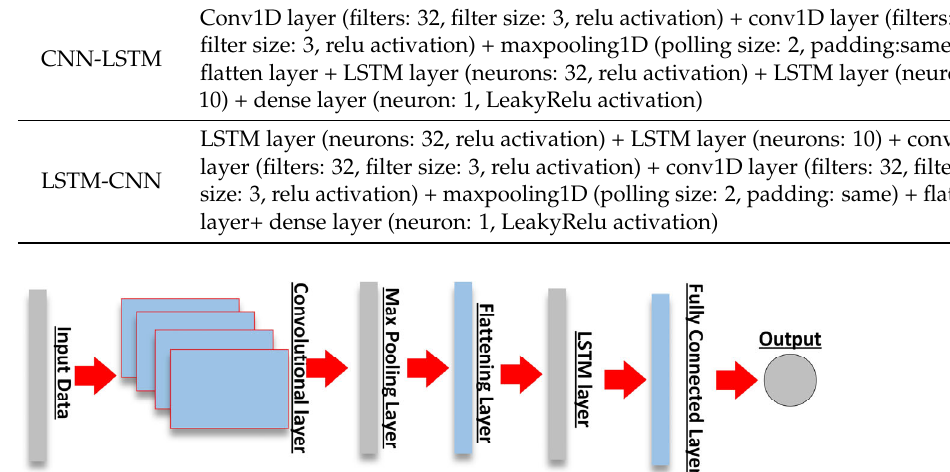
Figure 4. The structure of LSTM ‐ CNN model. 4. Methodology To compare the performance of CNN ‐ LSTM and LSTM ‐ CNN in predicting the direc ‐ tion of load flow of each line in the power grid, the proposed methodology is shown in Figure 5. The proposed approach is divided into four steps: data collection, pre ‐ processing of the data, creation of the models CNN ‐ LSTM and LSTM ‐ CNN and evaluation of the models. 4.1. Step 1: Data Collection Data collection is a crucial step because all further steps depend on the availability of the data. Data collection is about gathering all the necessary data from the available sources. It is important to clean and filter the data before it is used. In this work, the raw data for directional power flow is collected from a power grid under study and the weather data is obtained from a weather service provider. Therefore, the quality of the data used in this work is suitable for training and testing the proposed hybrid deep learn ‐ ing model for predicting the direction of power flow. 4.2. Step 2: Data Pre ‐ processing After data collection, the next step is to pre ‐ process the data. The main objective of this phase is to prepare and convert the raw data into a format suitable for the HDL model. The implementation of data pre ‐ processing is very important for any type of deep learn ‐ ing model as it can improve the model accuracy by improving the quality of the data and extracting valuable information from the data [36]. In this work, various data pre ‐ pro ‐ cessing techniques were used, ranging from normalising the data to splitting the dataset. 4.2.1. Data Normalization The datasets used in this study come from different sources, and their parameters have different units and scales. These differences in the datasets may affect the perfor ‐ mance of HDL during the learning process and, even worse, increase the generalisation